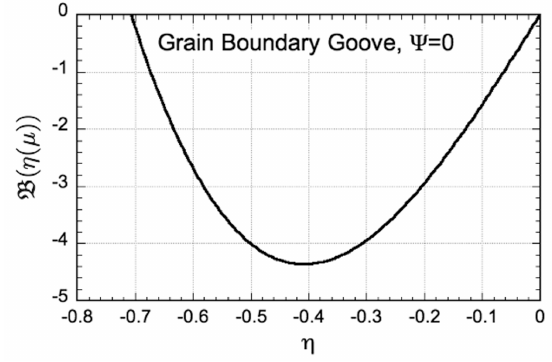
Figure 4. Plot of capillary-mediated energy rates, B ( η ( µ )) (Equation (18)) for an equilibrated grain boundary groove with zero dihedral angle, specified by Equation (4). Energy rates are negative at all points along the groove’s solid–liquid interface, indicating that heat removal, i.e., cooling, occurs √ everywhere along the interface. The most intense cooling rate occurs at η = − 1/ 6, roughly half-way −√ between the groove’s triple junction at η (cid:63) = 2/2 and the µ -axis, where η =